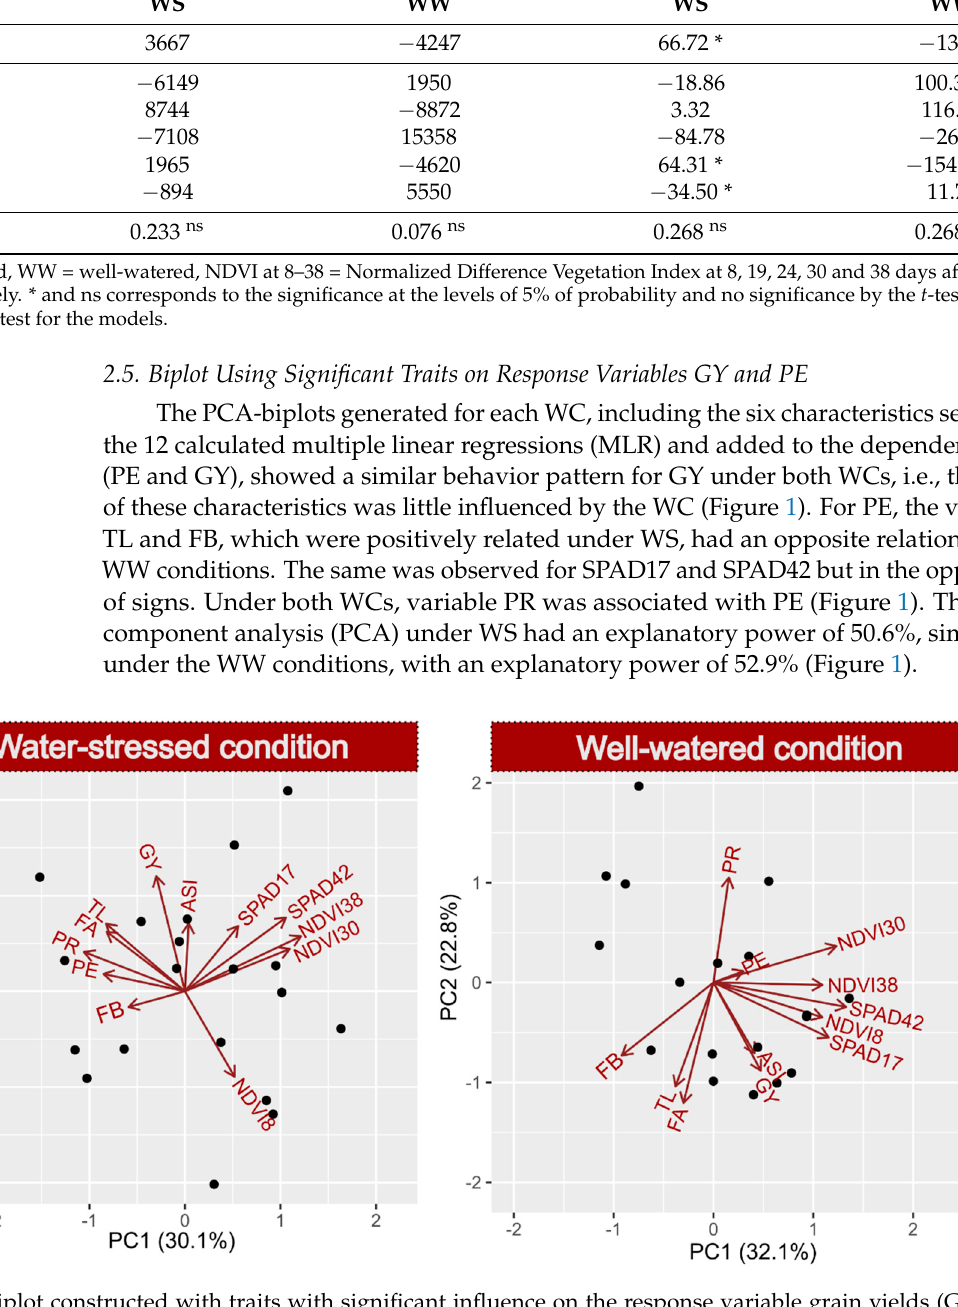
Table 4. Estimated beta values using multiple regression based on five Normalized Difference Vegetation Index (NDVI) measurements at 8, 19, 24, 30 and 38 days after male flowering (predictors) versus the grain yield (GY) and popping expansion (PE) (dependent variables) evaluated in 20 popcorn inbred lines under two water conditions (WCs).